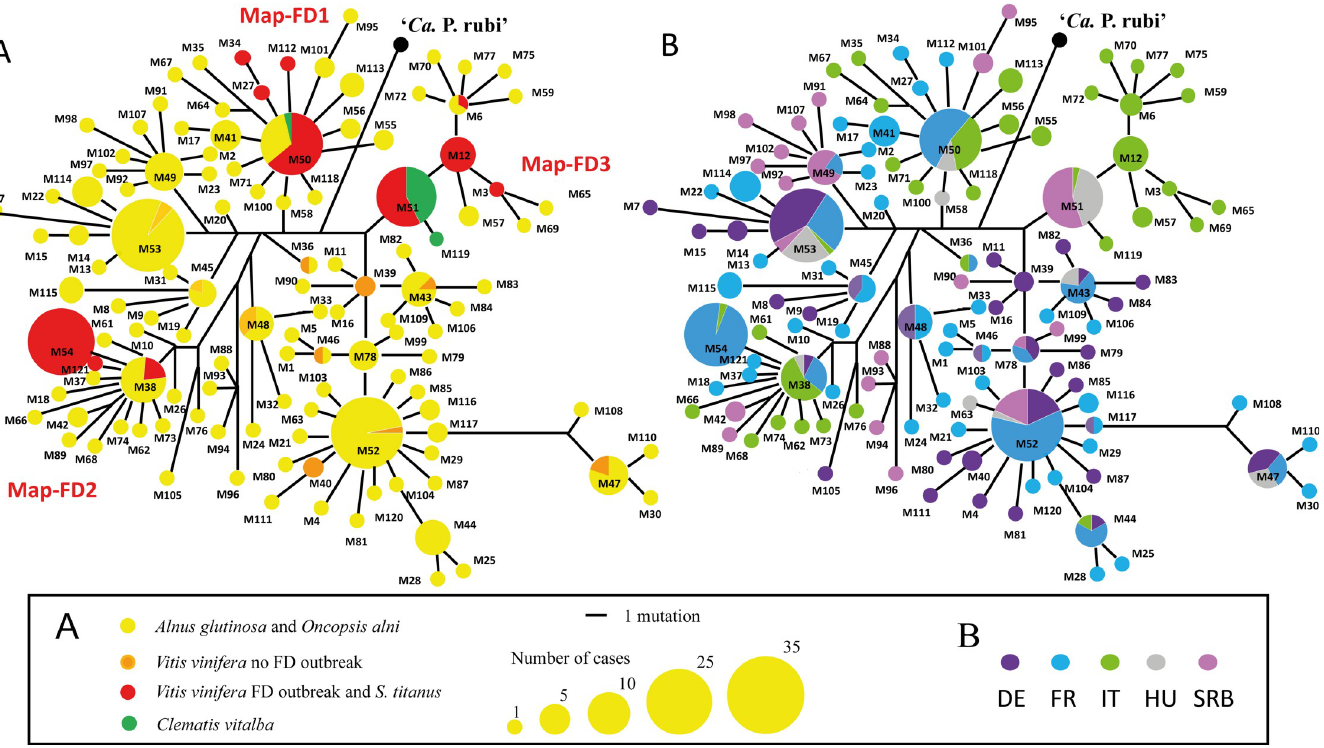
Fig 2. Genetic diversity of FD-related phytoplasmas in Europe. A. One of the trees constructed by parcimony analysis of the map gene nucleotide sequence (partial, 684bp) of the16SrV group phytoplasma isolates collected from Alnus sp . and O . alni (yellow), from Vitis sp . and S . titanus (orange and red) and from Clematis vitalba (green). Branch length is proportional to the number of inferred character state transformations and circle surface is proportional to the number of cases. B. Same tree representing the origin of phytoplasma isolates. France (F; light blue), Germany (G; purple), Hungary (H; grey), Italy (I; light green) and Serbia (SRB;